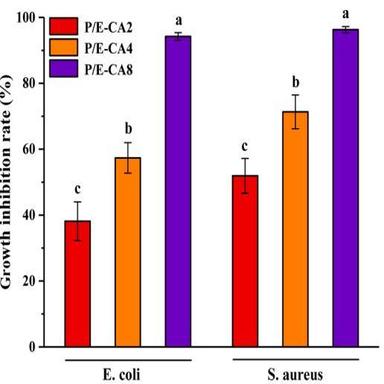
The growth inhibition rate (%) of P/E-CA composite nanofiber films against E. coli and S. aureus. Different letters indicate significant differences (P < 0.05).